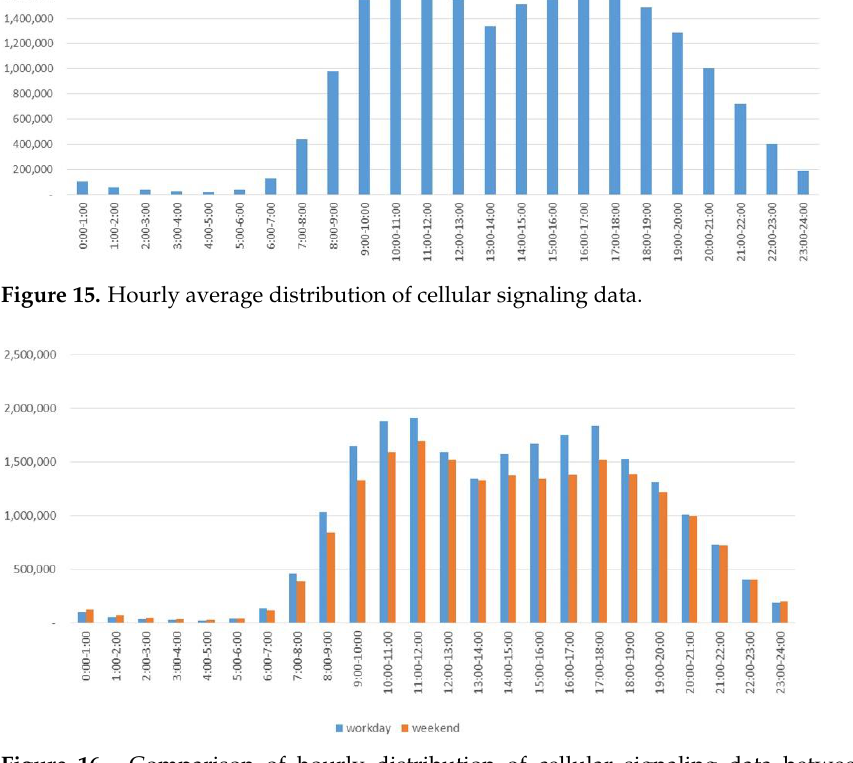
Figure 16. Comparison of hourly distribution of cellular signaling data between workdays and weekends.